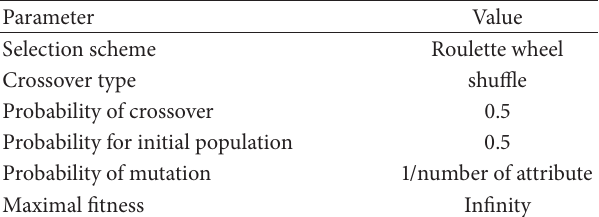
Table 1: Parameter values in